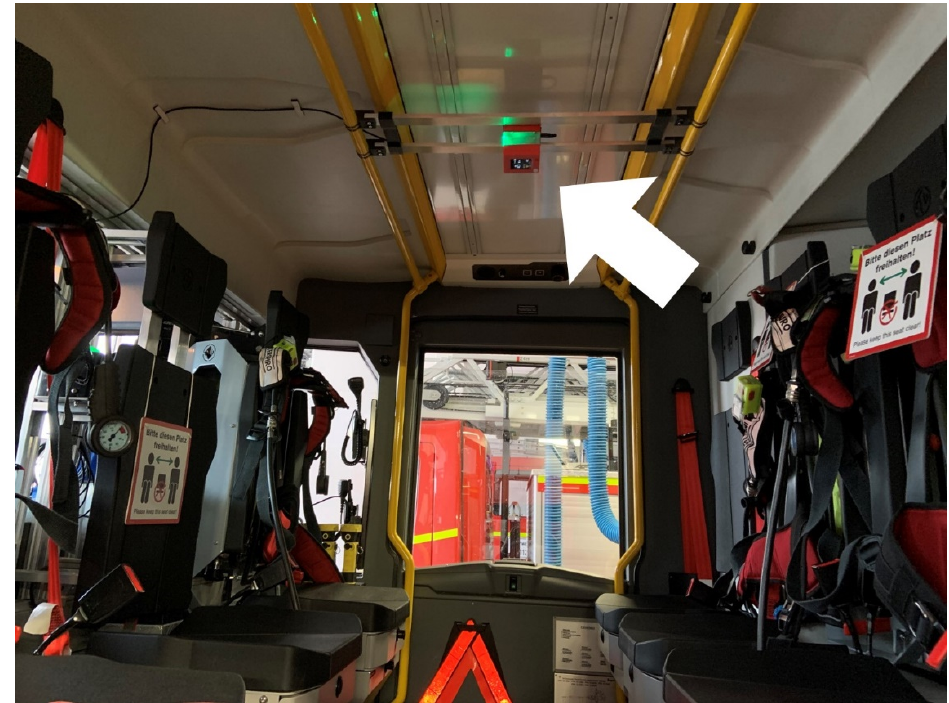
Figure 3. ProxiCube in back area position S2 (white arrow).